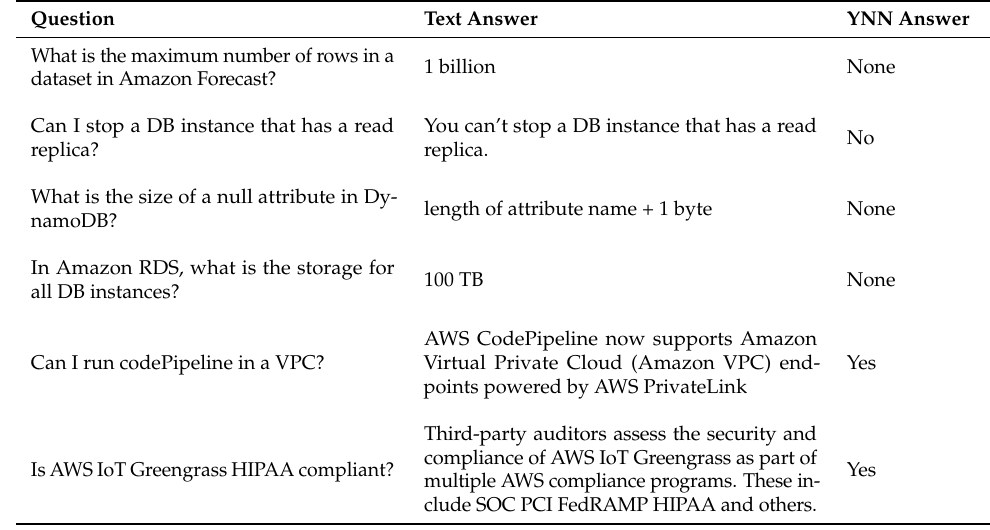
Table 1. Sample questions from AWS Documentation